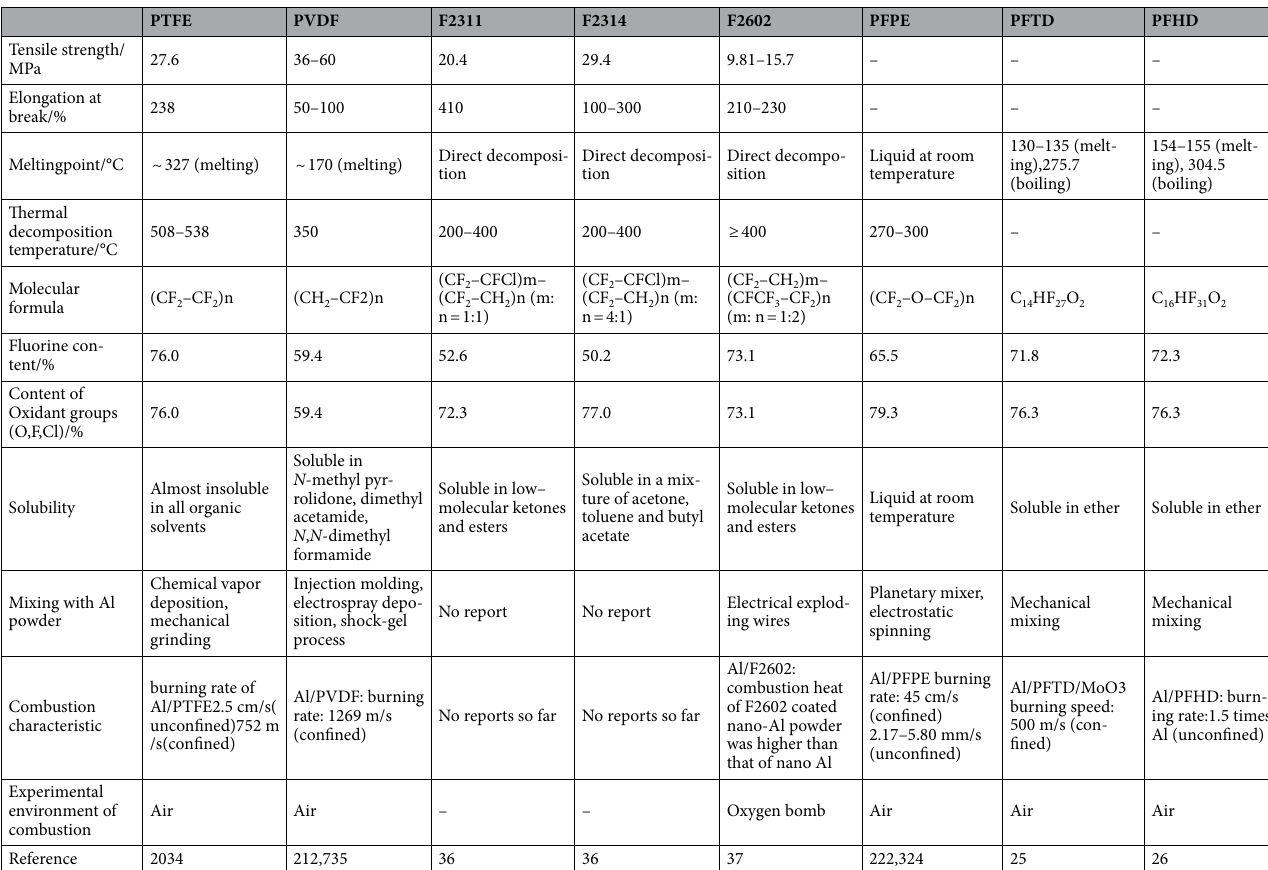
Table 1. Comparison of physical and chemical properties of various